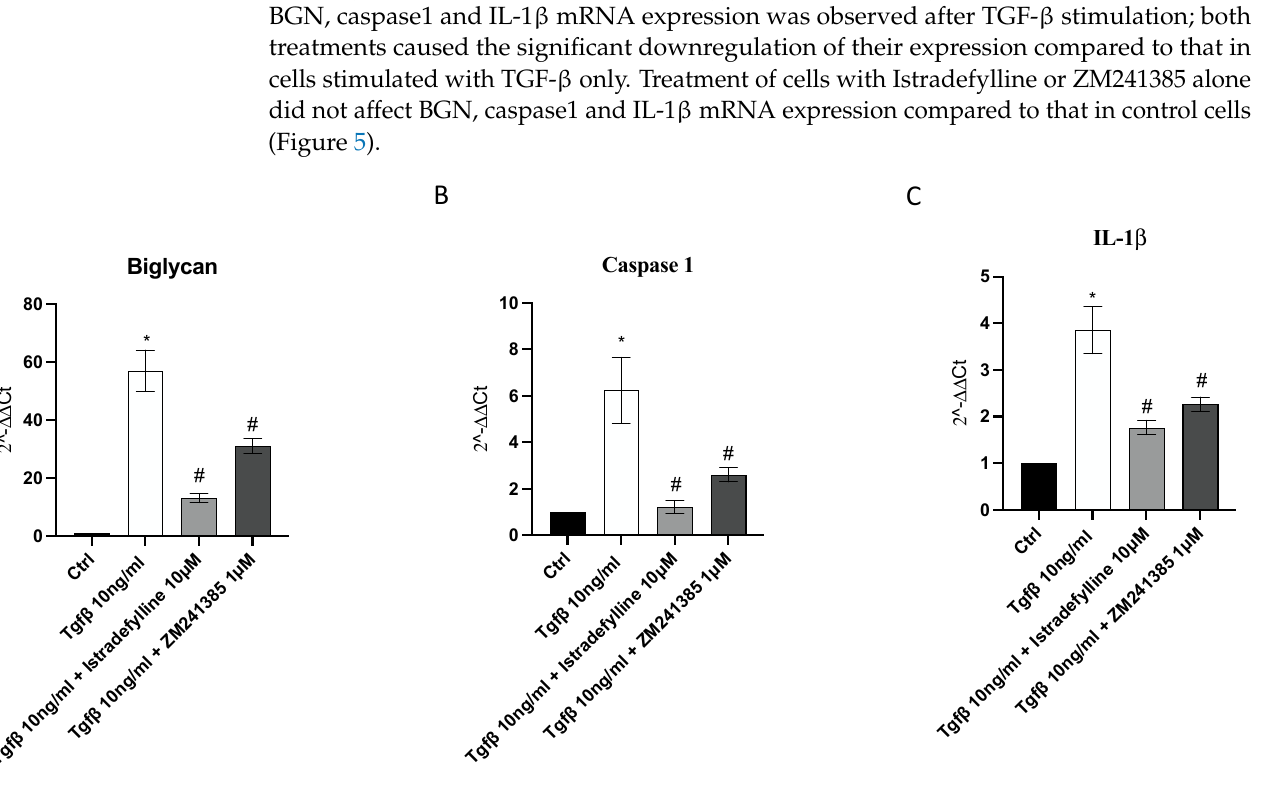
Figure 5. The graphs represent biglycan ( A ), caspase1 ( B ) and IL-1 β ( C ) mRNA expression assessed via RT-PCR in IM-HCF cells. The data are expressed as the means and SDs of five experiments. * p < 0.05 vs. CTRL; # p < 0.05 vs. TGF- β .